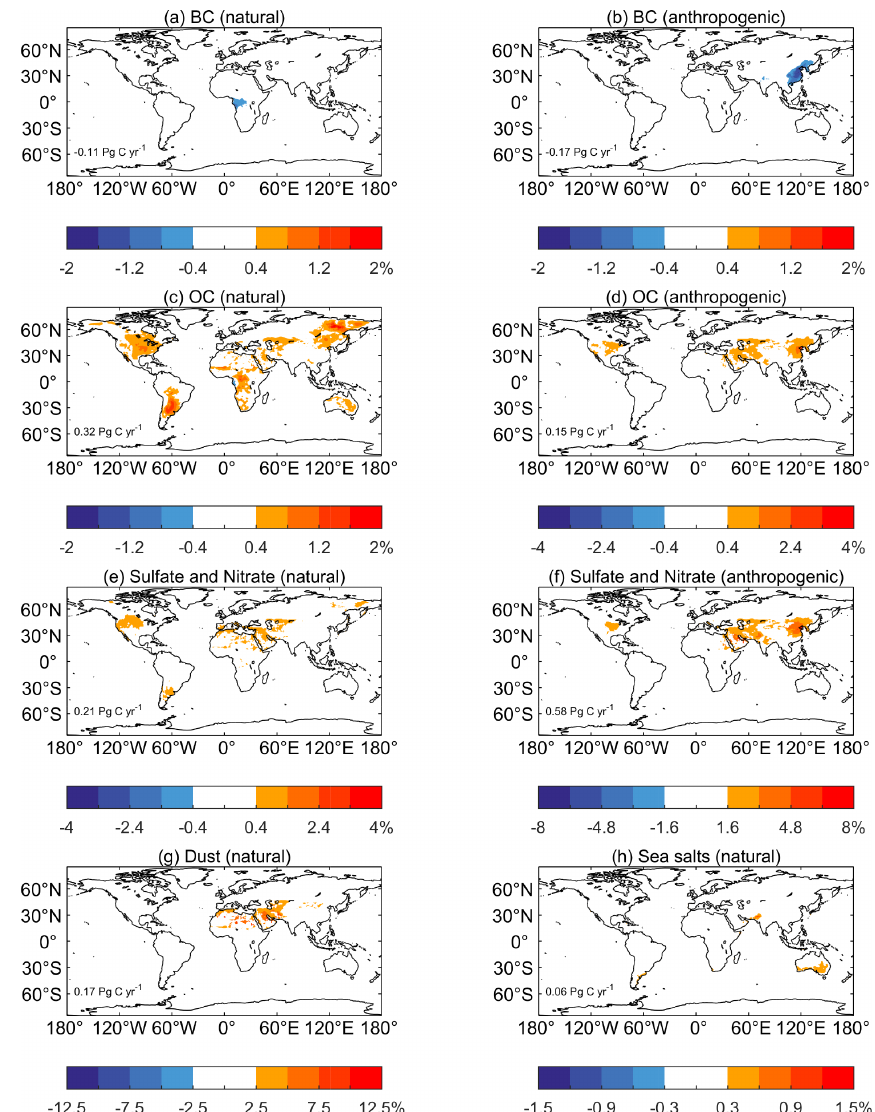
Figure 5. Percentage changes in annual GPP by specific natural and anthropogenic aerosols under all-sky conditions. The global changes in GPP caused by individual aerosol species (BC, OC, sulfate and nitrate, dust and sea salt aerosols) from different sources (natural and anthropogenic) are shown in corresponding panels. Please notice that the color scales for different aerosol species are different. The units are